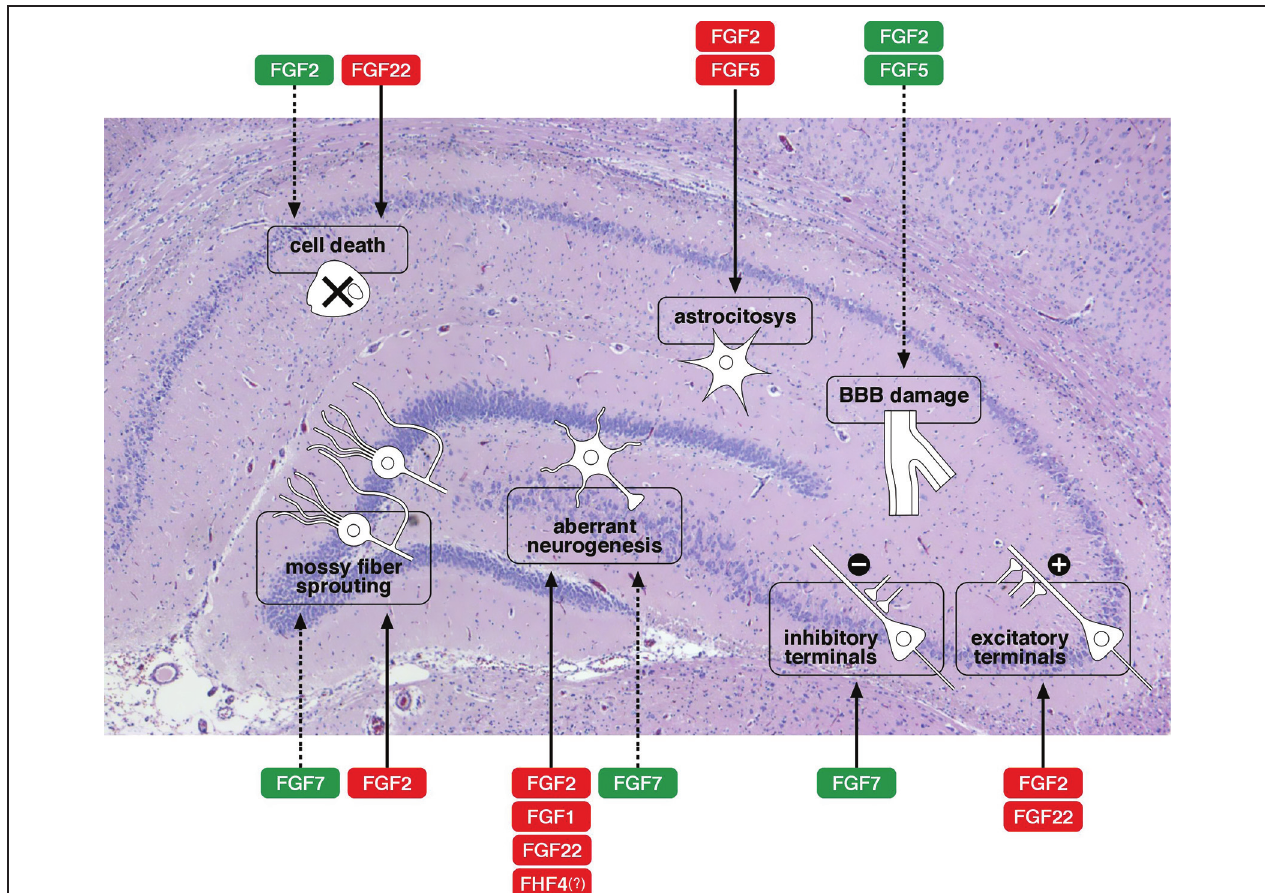
dentate gyrus hilus. Solid arrows indicate facilitation, dotted arrows inhibition of a specific event. The name of the FGF members is framed in red to indicate a putatively negative implication in epilepsy (favoring epileptogenesis), in green to indicate a putatively positive implication (contrasting epileptogenesis). Note that these are only tentative indications, because evidence regarding the FGFs is often fragmentary and because the patho-physiological consequences of each alteration are sometimes